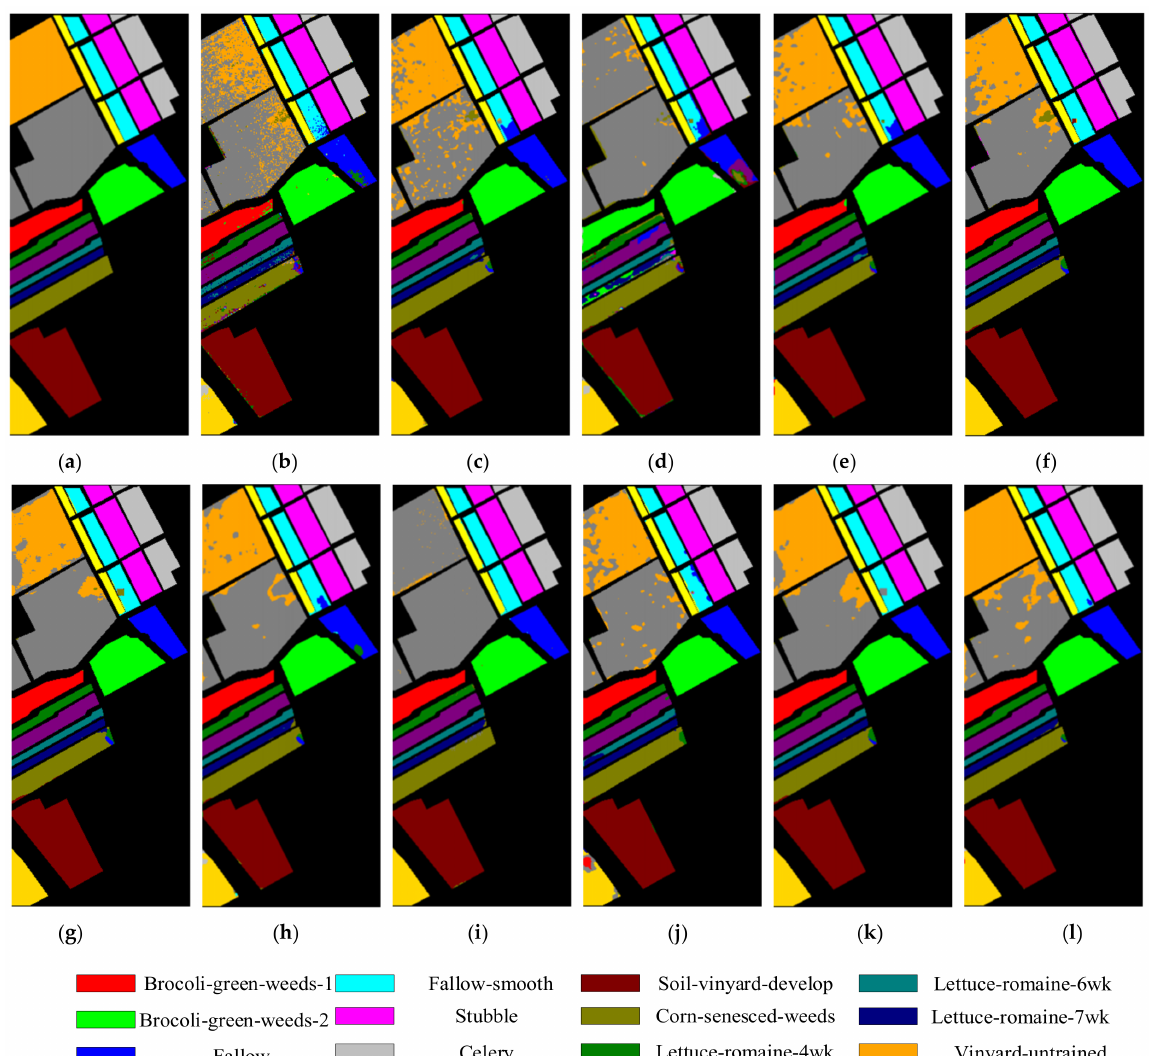
Figure 10. Full classification maps on the Salinas Valley images obtained with the ( a ) ground truth, ( b ) KNN (OA = 82.17), ( c ) SVM-RBF (OA = 88.09), ( d ) CDCNN (OA = 80.51), ( e ) SSRN (OA = 90.11), ( f ) FDSSC (OA = 94.60), ( g ) DHCNet (OA = 94.45), ( h ) DBMA (OA = 92.62), ( i ) HybridSN (OA = 95.05), ( j ) DBDA (OA = 95.81), ( k ) LiteDepthwiseNet (OA = 97.02), and ( l ) proposed method (OA =